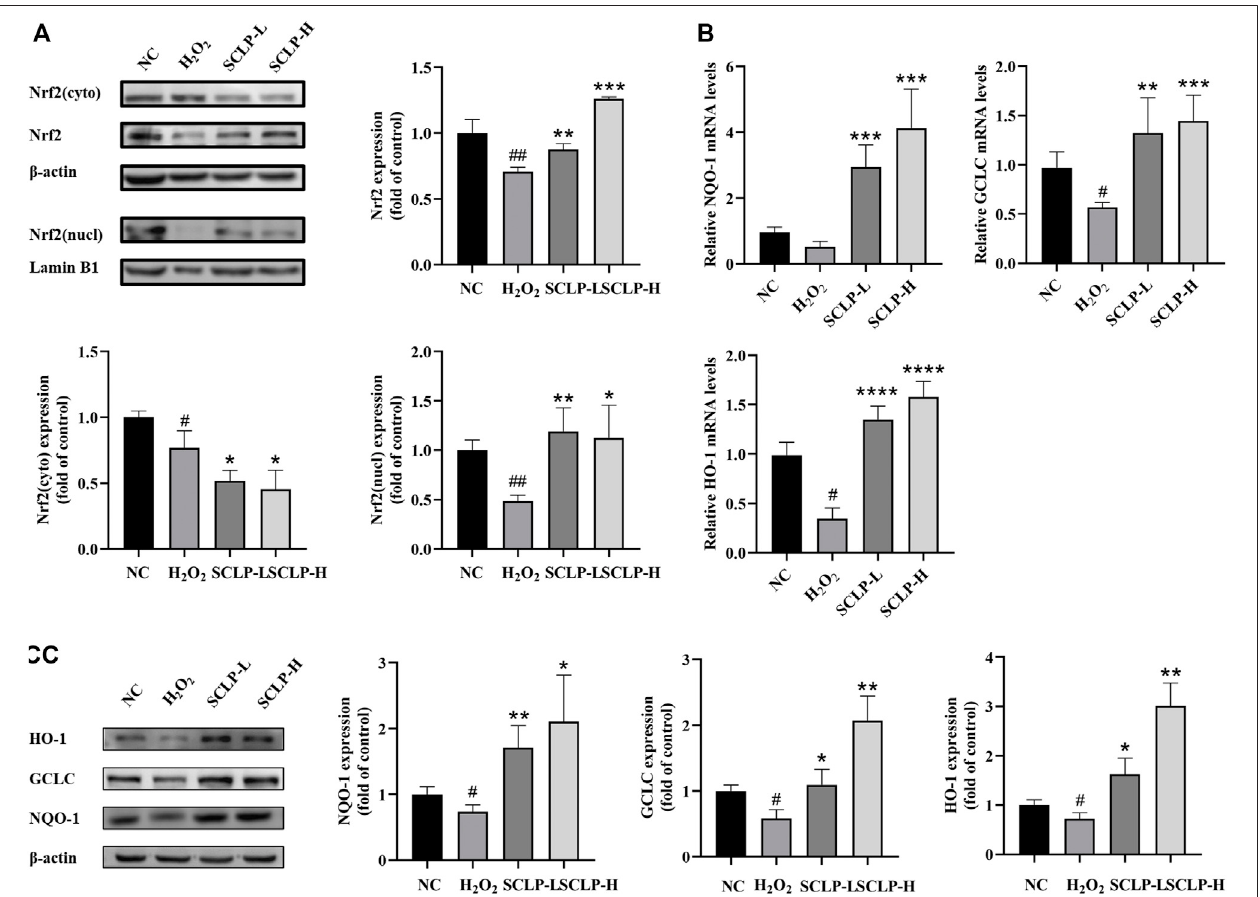
FIGURE 7 | SCLP activated Nrf2-ARE signaling pathway and increased the transcription and expression of antioxidant enzymes in vitro . (A) the effect of SCLP on expression andnucleartranslocationofNrf2protein; (B,C) theeffectofSCLPontranslation andexpressionofNQO-1, GCLCandHO-1proteins. Dataarepresentedas the mean ± S.D. ( n = 3). # p < 0.05, ## p < 0.01, ### p < 0.001 vs. NC. * p < 0.05, ** p < 0.01, *** p < 0.001, **** p < 0.0001 vs. H 2 O 2